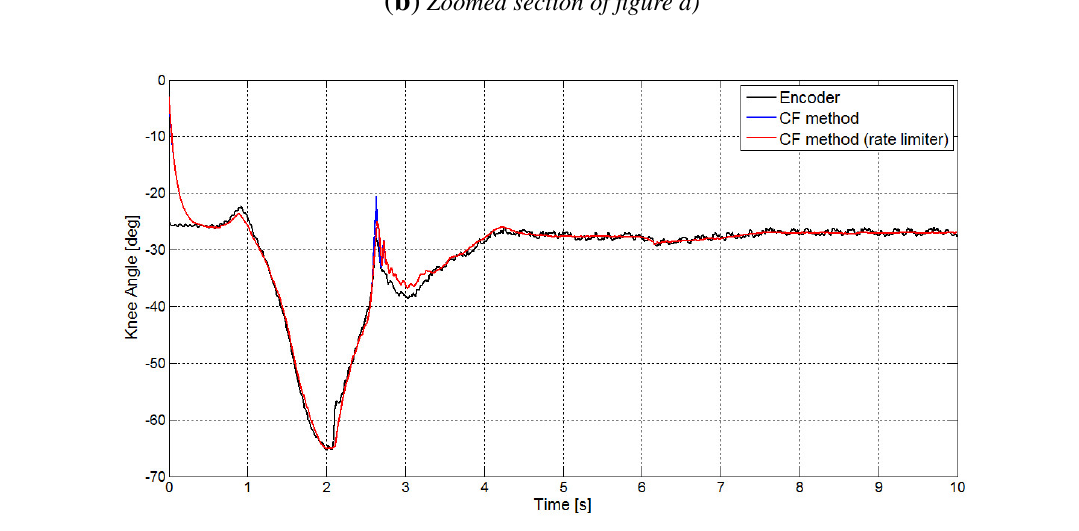
( c ) Encoder vs. estimation methods